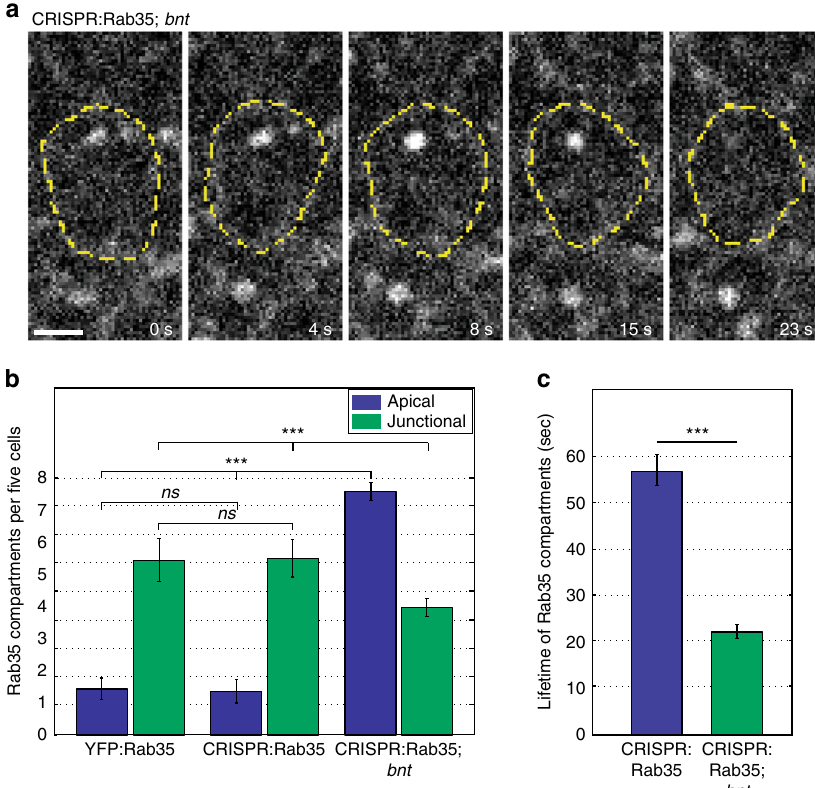
Fig. 4 The Rab35 ratchet is engaged by AP patterning. a – c Rab35 compartments localize apically away from cell interfaces and possess reduced lifetimes in embryos lacking AP patterning ( bicoid nanos torsolike , bnt , mutant embryos). a Rapid Rab35 compartmental formation and termination at the apical surface in bnt embryos (cell outline marked in yellow ). b , c Majority of Rab35 compartments form apically ( b ) and possess decreased lifetimes (total lifetimes of apical and interfacial compartments, c ) in bnt mutant embryos. n = 681 (YFP:Rab35), 454 (CRISPR:GFP:Rab35), and 782 (CRISPR:GFP:Rab35; bnt ) compartments. Mann – Whitney U Test, *** P < 0.0005. Error bars indicate standard error. Scale bar is 2.5